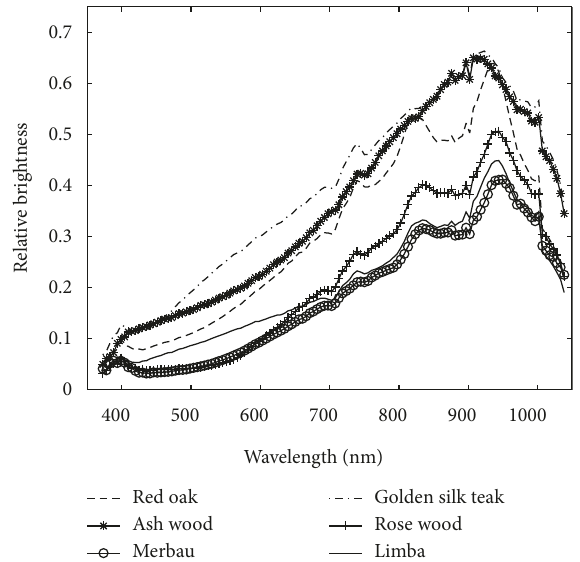
Figure 4: Spectral difference in wood vessels’ peripheral region for six hardwood